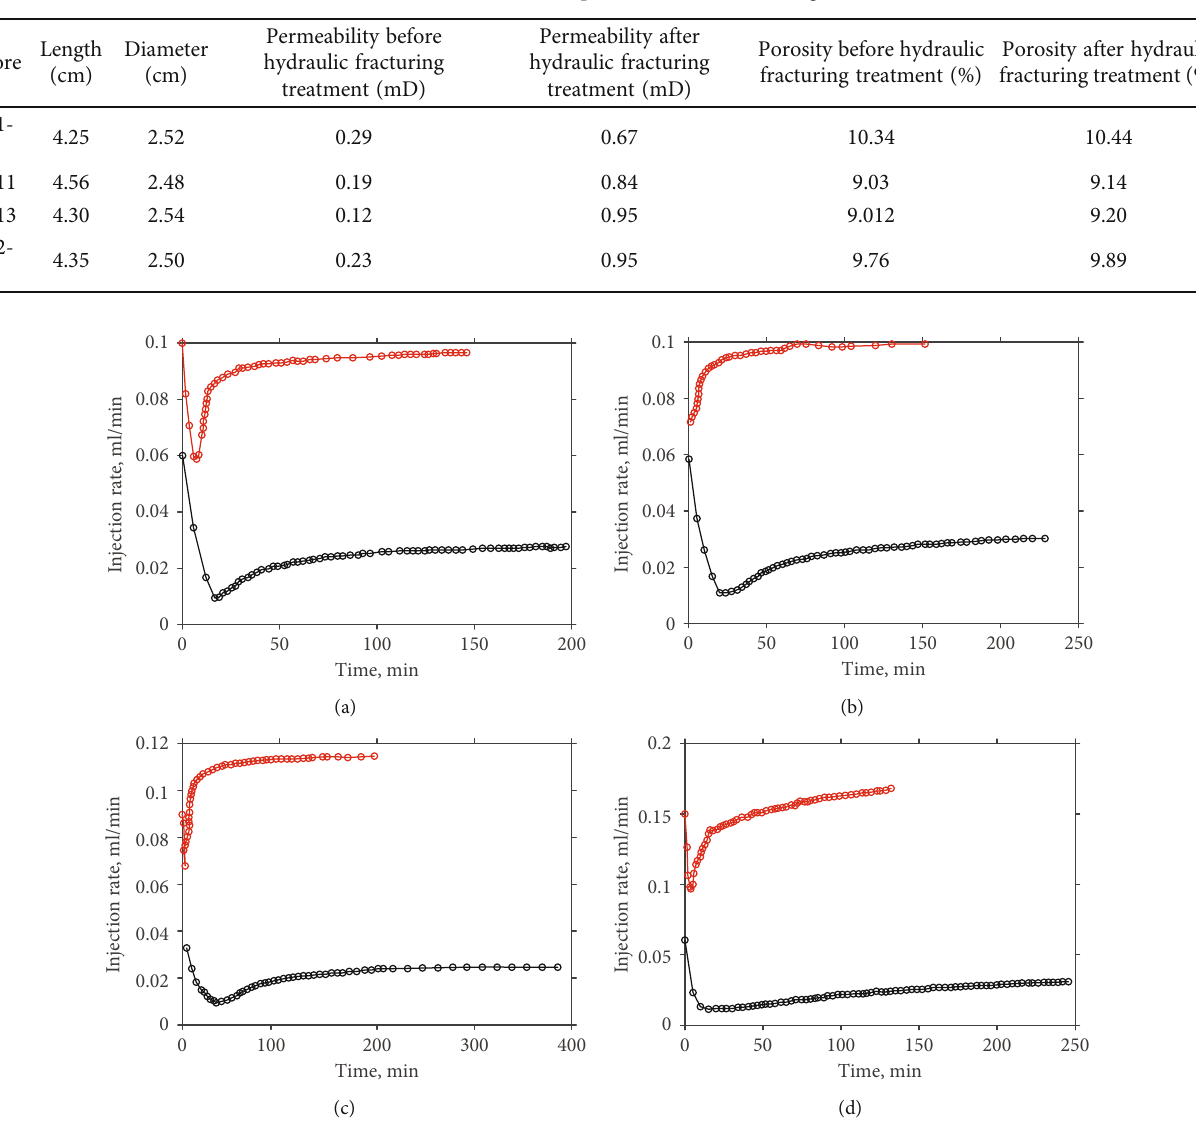
Figure 4: Injection velocity pro fi le with respect to the water fl ooding time before and after the construction of fracture in the experimental core. The red and black points represent the results before and after the construction of fracture. (a) Cores H1-5. (b) Cores H11. (c) Cores H13. (d) Cores